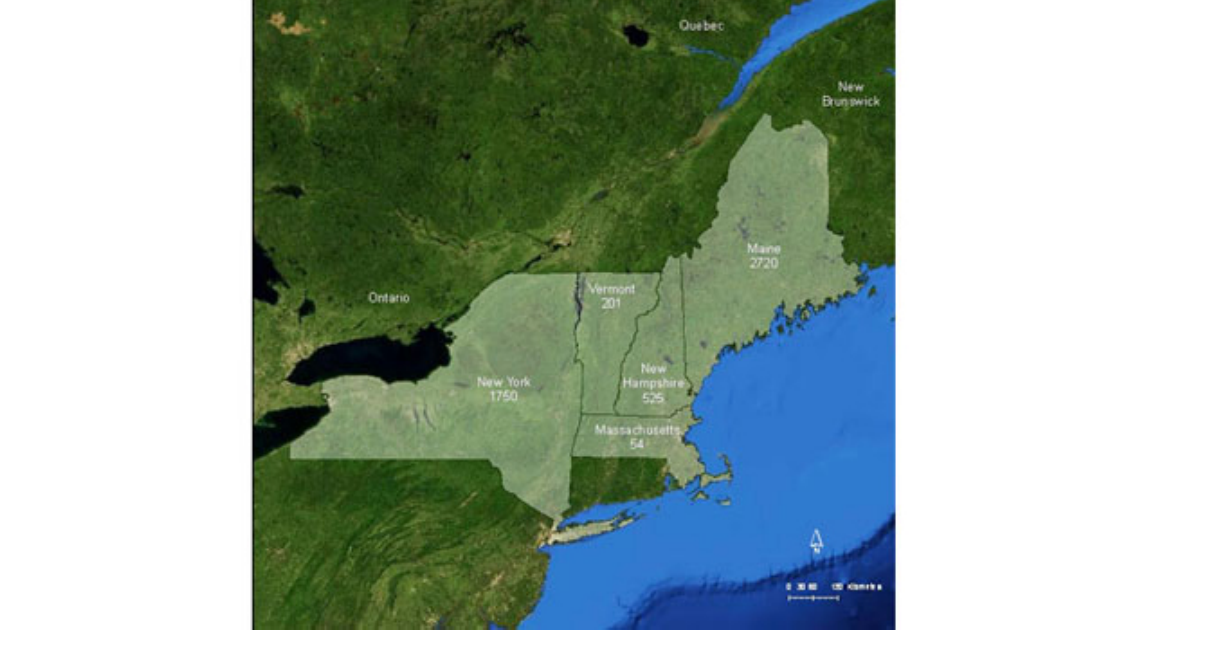
Fig. 1. Average number of adult Common Loon in the northeastern United States from 2004 to 2008. Data sources: New York Adirondack Center for Loon Conservation (http://www.briloon.org/science-and conservation/centers/adirondackloons.php), Vermont Center for Ecostudies (2007 breeding status of Common Loon in Vermont, http://www.vtecostudies.org/PDF/Loonreport07%20final.pdf), New Hampshire Loon Preservation Committee, Maine Audubon Society (The Maine Loon Project, http:// www.maineaudubon.org/conserve/loon/index.shtml), and Massachusetts Department of Conservation and Recreation